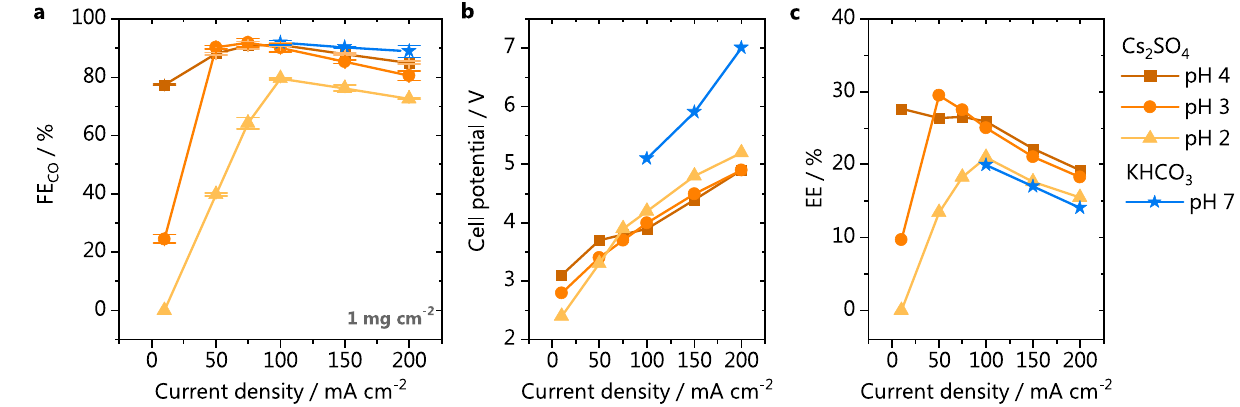
Fig. 3 Comparison between acidic and neutral media. a Faradaic ef fi ciency for CO; ( b ) cell potential and ( c ) energy ef fi ciency for CO 2 electrolysis performed in either 1 M Cs 2 SO 4 (orange) or 1 M KHCO 3 (blue stars), catalyst loading 1 mg cm − 2